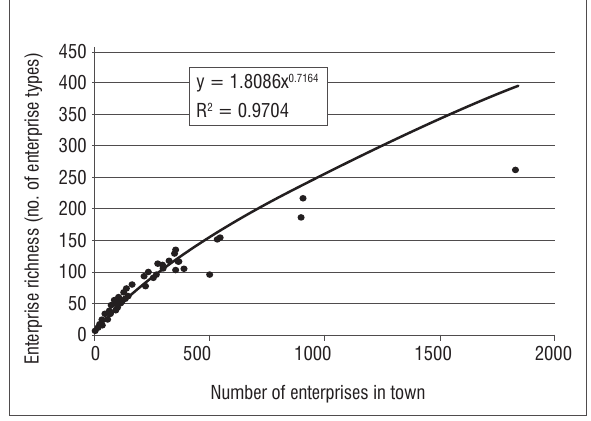
Enterprise richness as a function of the total enterprise numbers of 134 South African